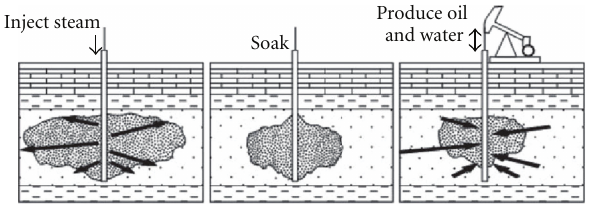
Figure 2: Cyclic steam stimulation